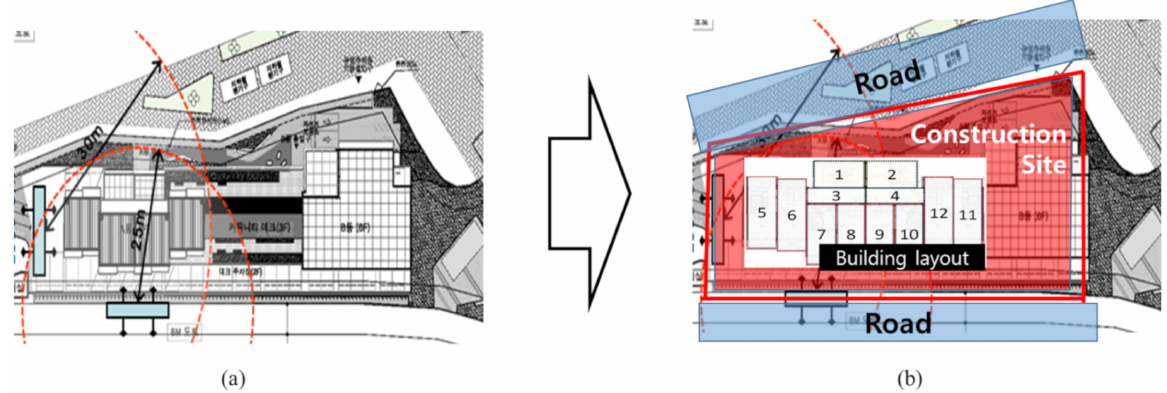
Figure 2. Conversion of site conditions into coordinates (legend: ( a ) is the initial construction plan, ( b ) is the road shape and building layout area of the initial construction plan).